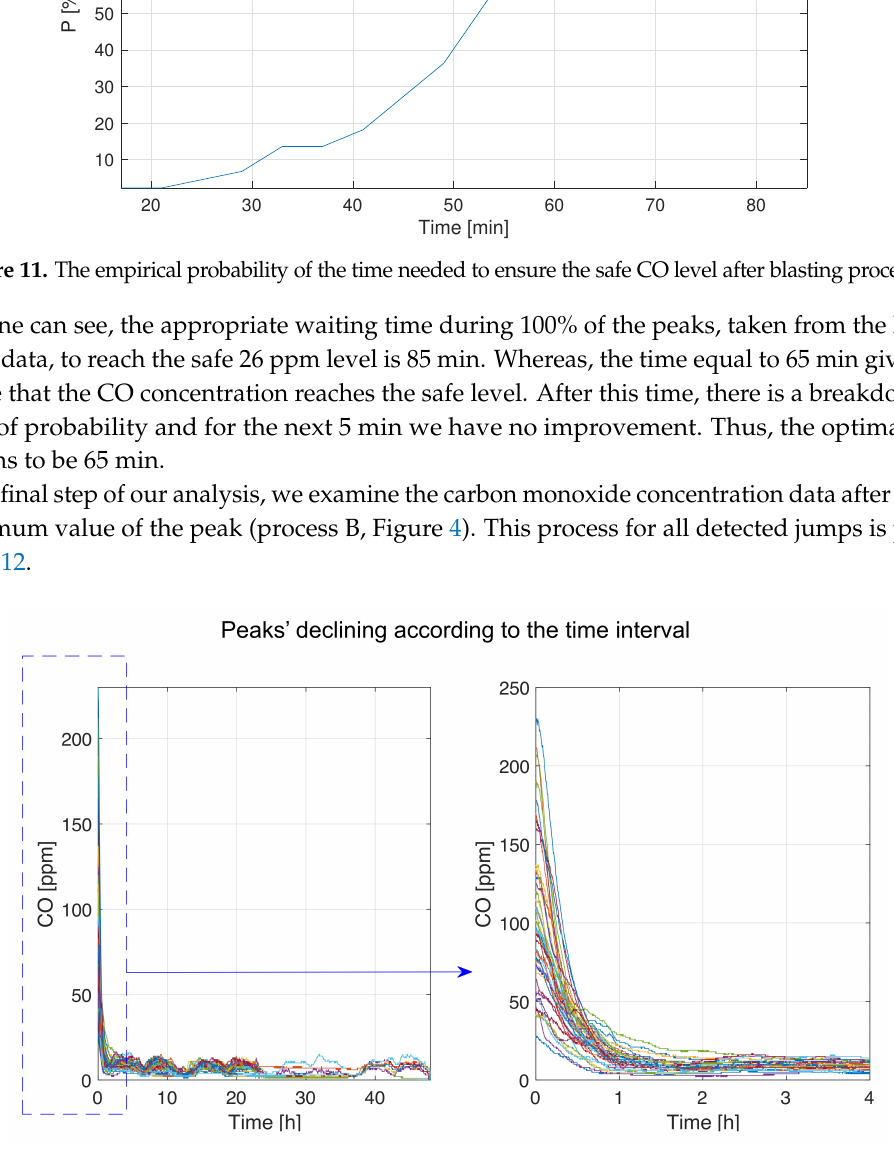
Figure 12. The carbon monoxide concentration variation following maximum values